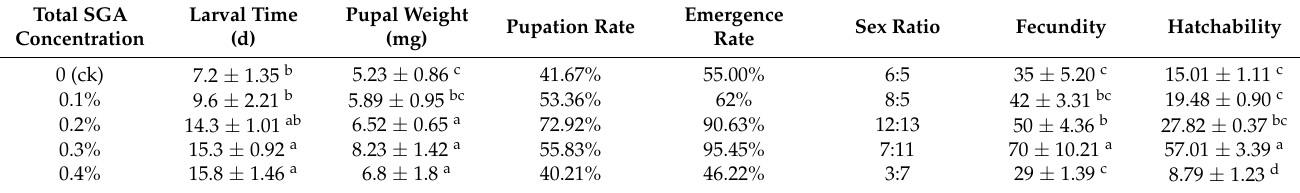
Table 3. The mean ( ± SE) reproduction parameters of P. operculella for different SGA concentrations in the artificial